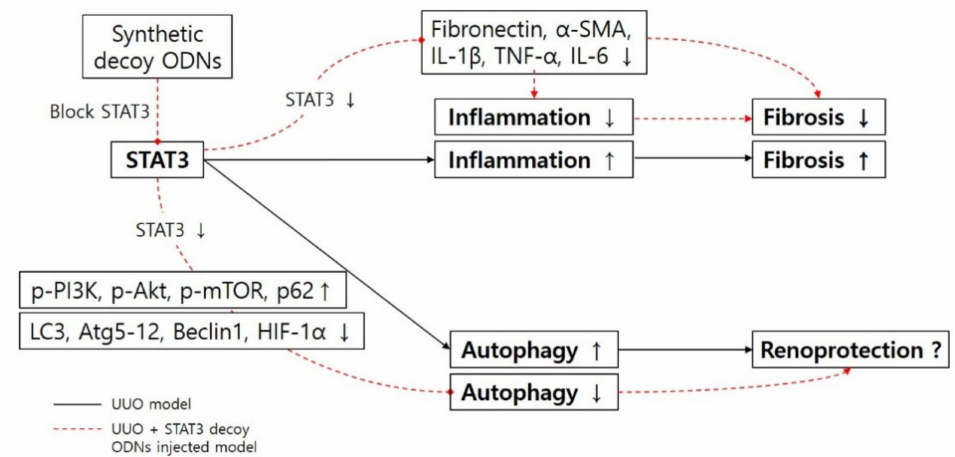
Figure 7. Schematic diagram of the molecular pathway for STAT3 transcription factor and inhibitory effects of synthetic decoy ODNs on autophagy in renal fibrosis. Abbreviations: UUO, unilateral ureteral obstruction; decoy ODNs, de- coy oligonucleotides; STAT3, signal transducer and activator of transcription 3; α -SMA, α -smooth muscle actin; IL-1 β , interleukin-1 β ; TNF- α , tumor necrosis factor- α ; IL-6, interleukin-6; p -PI3K, phospho-phosphoinositide 3-kinase; p -Akt, phospho-protein kinase B; p -mTOR, phospho-mammalian target of rapamycin; LC3, microtubule-associated protein light chain 3; Atg5-12, autophagy-related 5-12; HIF-1 α , hypoxia inducible factor-1 α